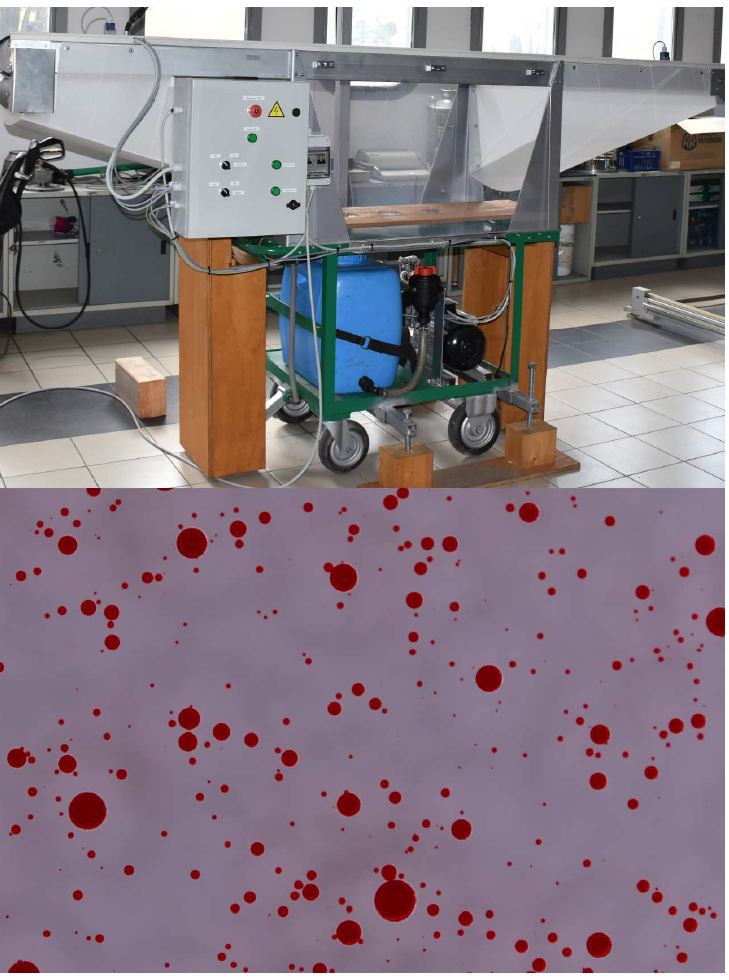
Figure 7. Test bench exploiting the liquid immersion method and example of drops (water solution with soluble red tracer) captured in Petri dishes containing silicone oil [83]. Red color simplifies drop feature extraction during image processing with ImageJ.